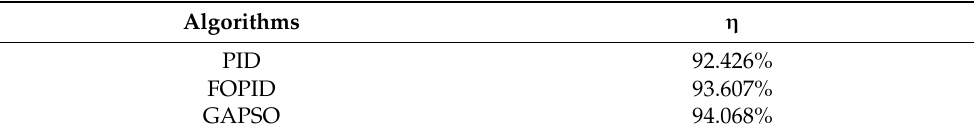
Figure 23. L = 27 m, V = − 0.2 m/s, rope tension and hydrodynamic forces without using adding wave synchronization strategy.